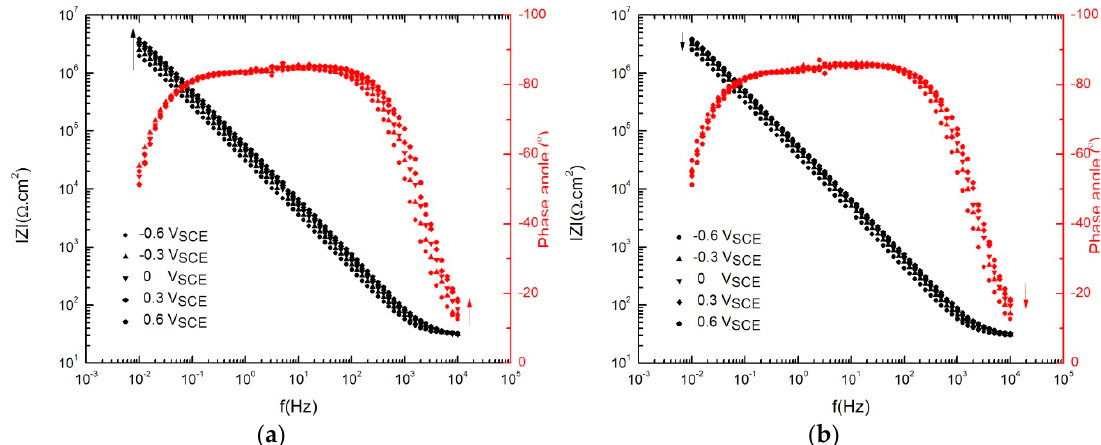
Figure 4. Electrochemical impedance spectroscopy (EIS) spectra of AA2098–T851 alloy after 24 h of polarization in contact with 1 atm CO 2 (pH = 6.7, 25 °C) with high-to-low frequency scan, ( a ) anodic potential stepping direction, ( b ) cathodic potential stepping direction.